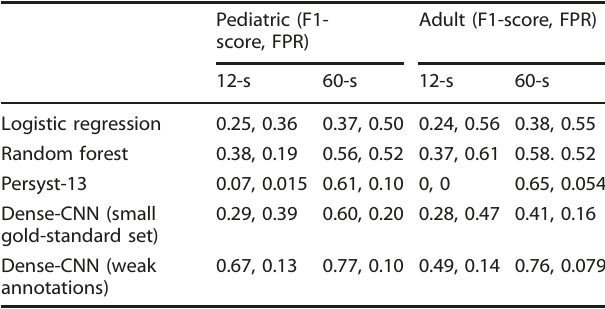
Comparison of baseline models to the weakly supervised CNN using the F1-score and FPR